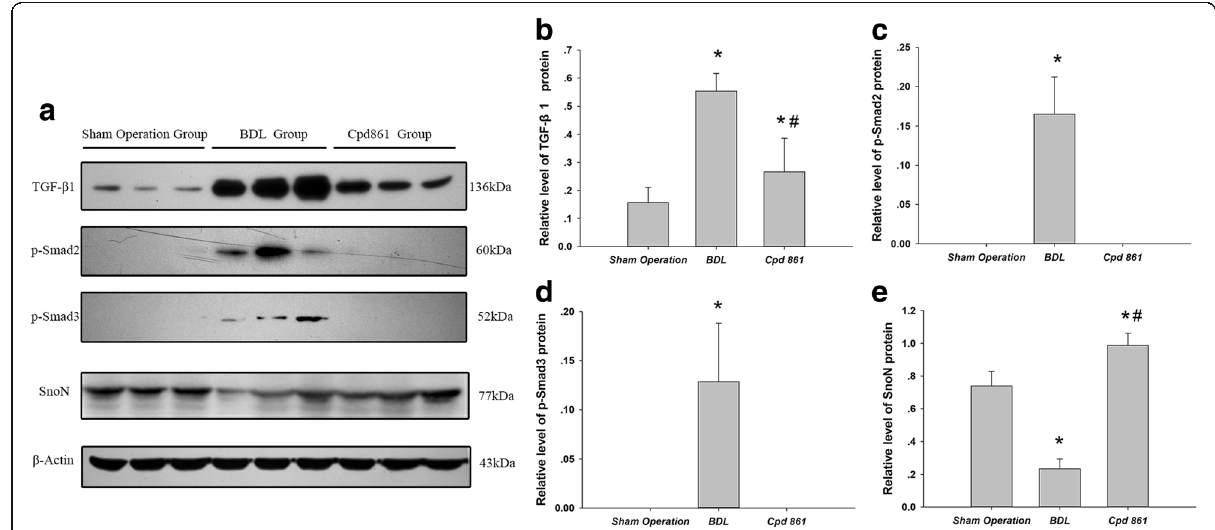
Fig. 5 a Expression levels of TGF- β 1, p-Smad2, p-Smad3, SnoN, and β -actin were detected by Western blot, with β -actin used as a loading control. Quantification of Western blots for relative levels of ( b ) TGF- β 1, ( c ) p-Smad2, ( d ) p-Smad3, and ( e ) SnoN. Data are expressed as means ± standard deviations ( n = 6). One-way analysis of variance was used for statistical comparisons. * P < 0.05 vs sham operation group; # P < 0.05 vs BDL